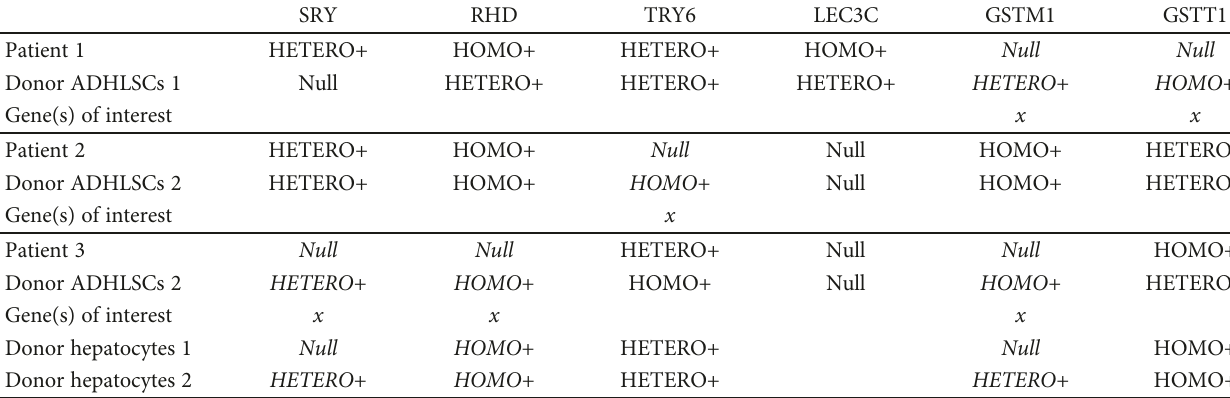
Table 3: Genotypes and genes of